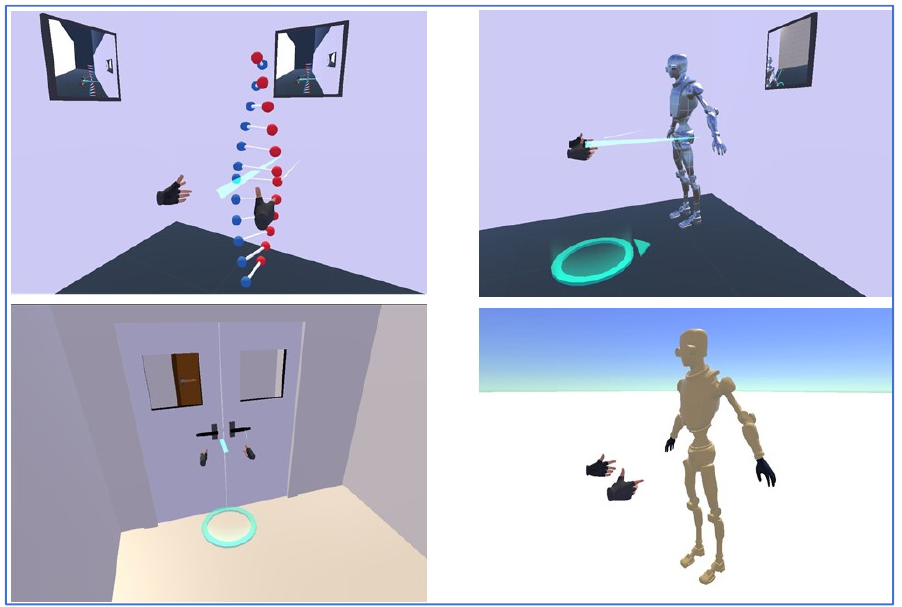
Figure 4. Different virtual reality (VR) games that can be used in association with the exoskeleton, such as manipulating the coloured balls, moving the robot’s arms, opening a door, controlling the android robot, in clockwise order from top-left.